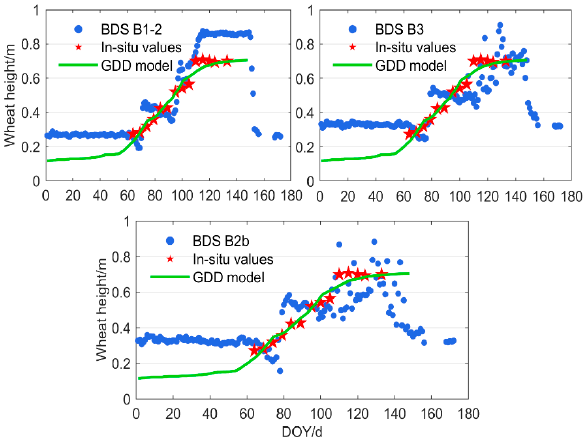
Figure 10. Wheat height retrieval with BDS.